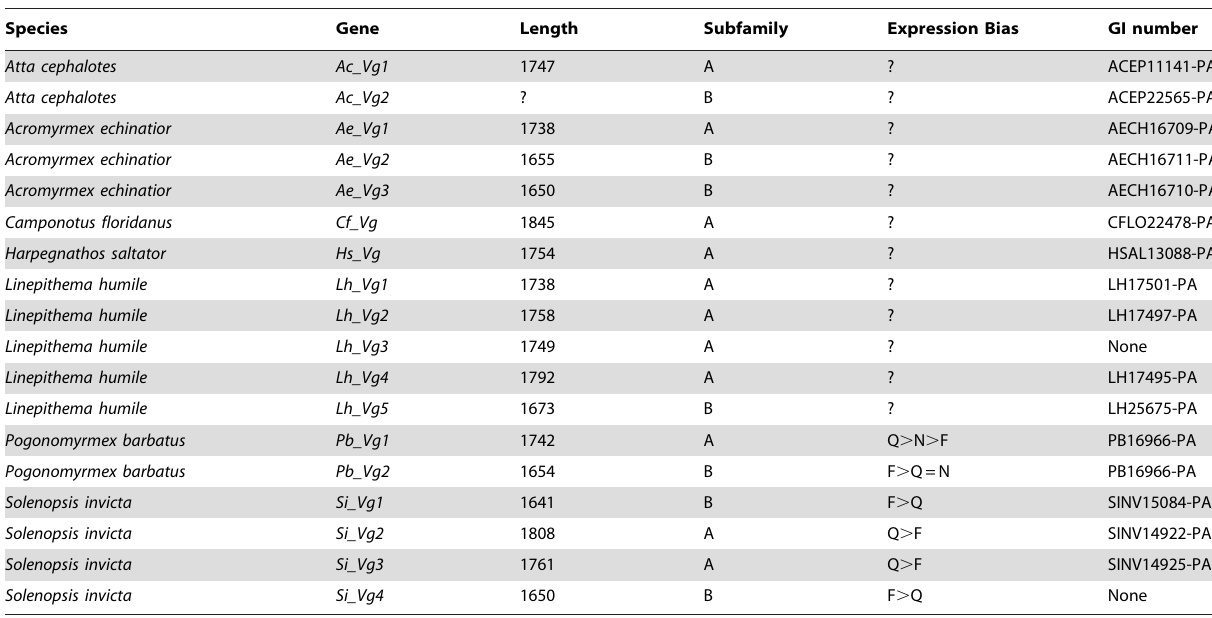
Table 1. Predicted protein length of Vg genes in ants.